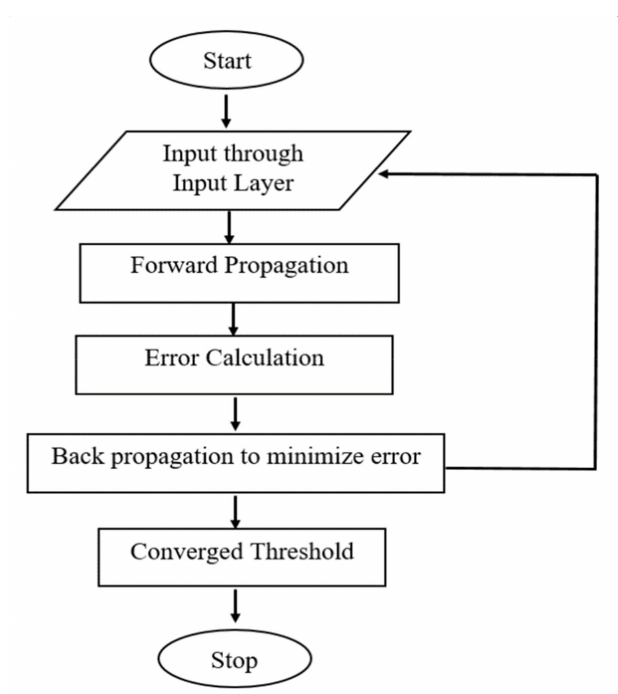
Figure 2. The multi-layer perceptron.